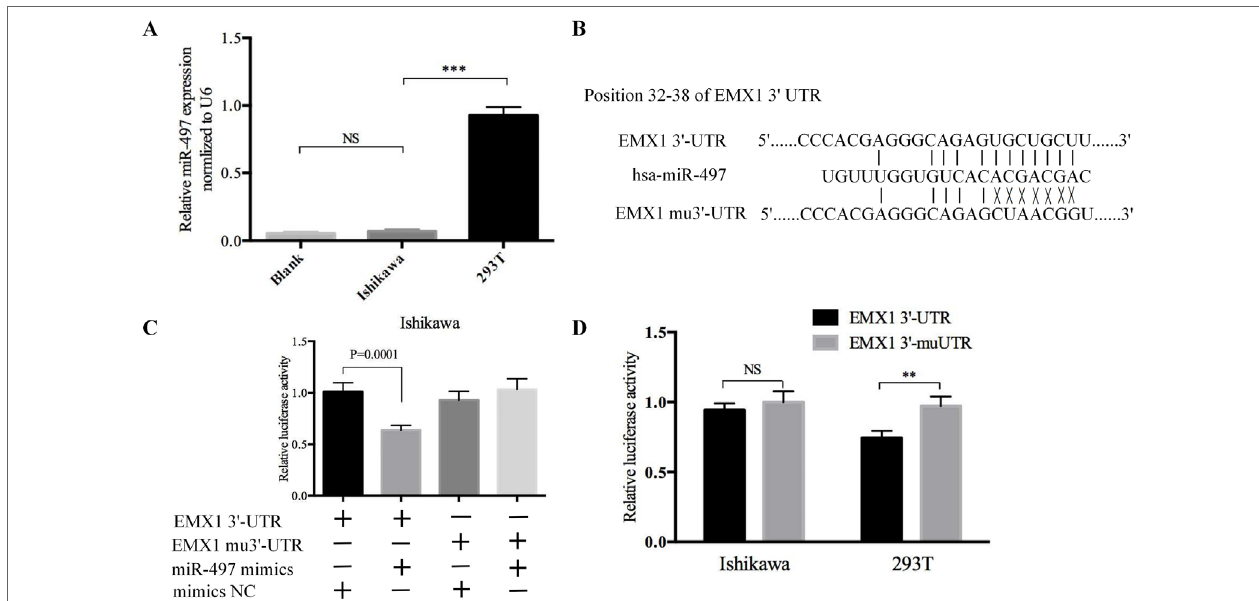
FIGURE 8 | The luciferase reporter assay confirmed that EMX1 was a direct target of miR-497. (A) The expression levels of miR-497 in Ishikawa and 293T cells. (B) The seed regions of miR-497 of EMX1 3 ′ -UTR and mu3 ′ -UTR. (C) The luciferase activity of Ishikawa cells co-transfected with miR-497 mimics or mimics NC,